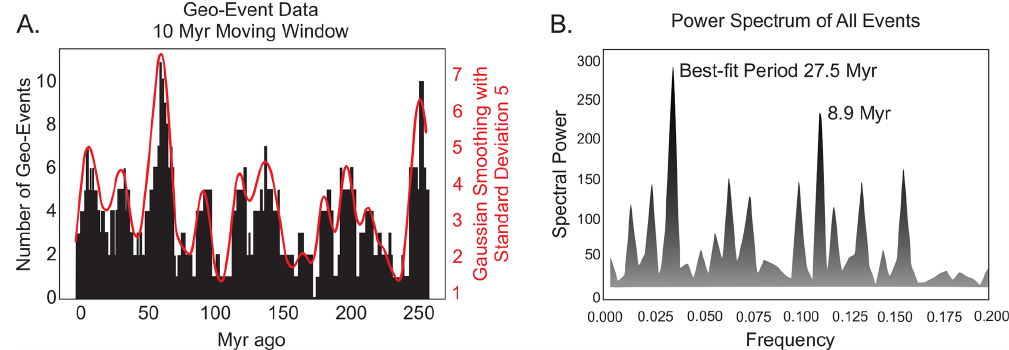
Figure 1. (a) Analysis of the ages of 89 geologic events using a 10Myr moving window centred every 0.5Myr, with the number of occur- rences that fall within the moving window computed at 1Myr intervals. Ten clusters (peaks) are visible. In red is the Gaussian smoothing with a standard deviation of 5Myr centred at every 0.1Myr, with 10 peaks. (b) Fourier transform results show the highest peak in 27.5Myr, and a strong secondary period occurs at 8.9Myr (modified from Rampino et al.,